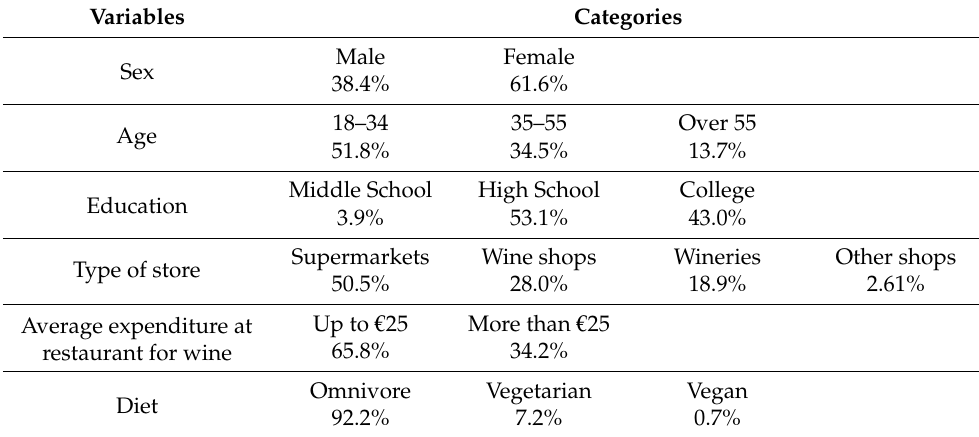
Table 1. Descriptive